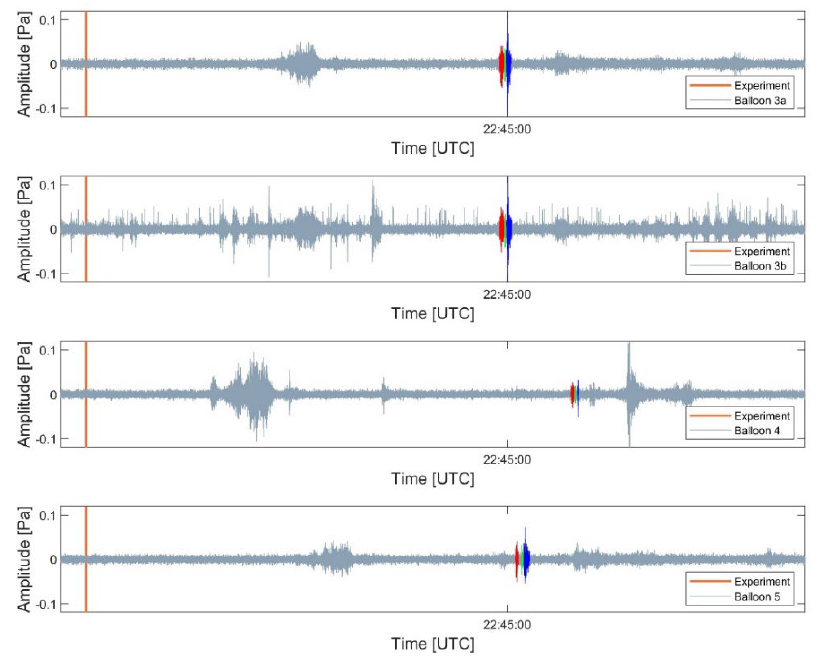
Figure 5. Filtered (high-pass Butterworth, >1 Hz) timeseries from all four sensors. The top two are from the 2-element vertical array suspended from Balloon 3. The top and bottom sensors are denoted as Balloon 3a and Balloon 3b, respectively. The signal exhibits multiple phases–the three phases are plotted in red, green and blue for better visualization. The vertical orange line denotes the detonation time (22:35 UTC). The amplitude scale is the same in all panels.